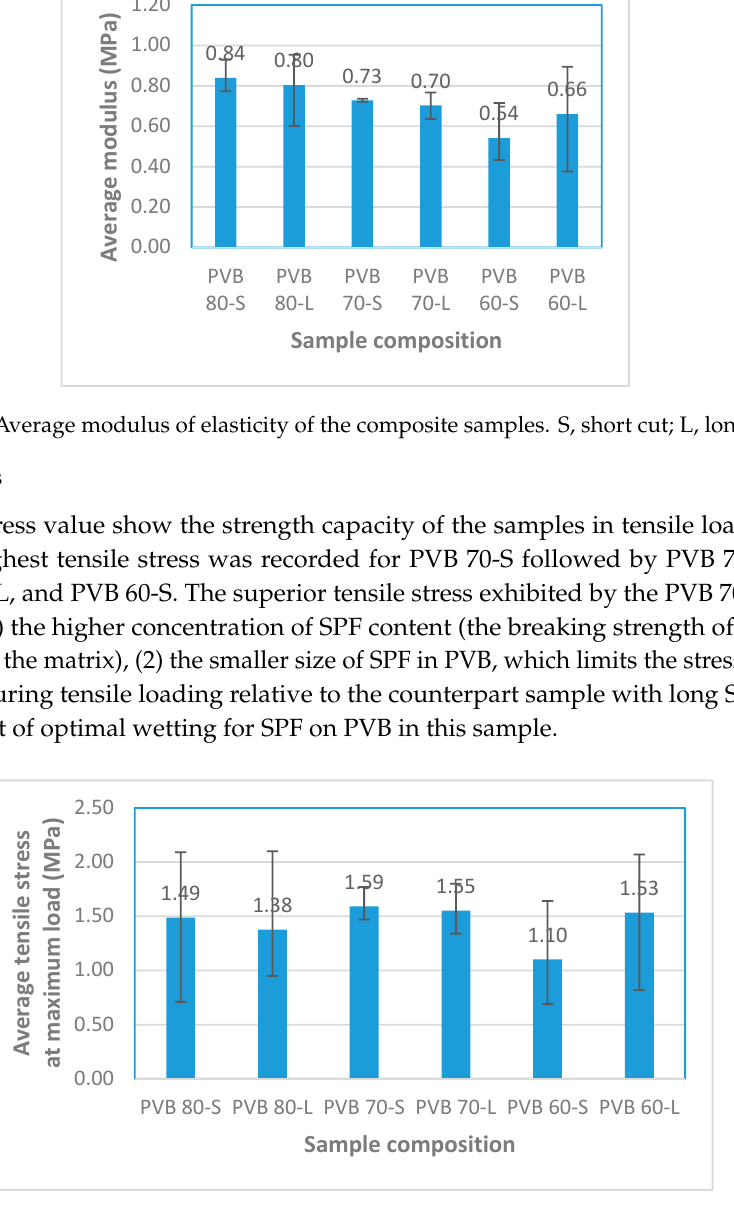
Figure 5. Average tensile stress at maximum load of the composite samples .